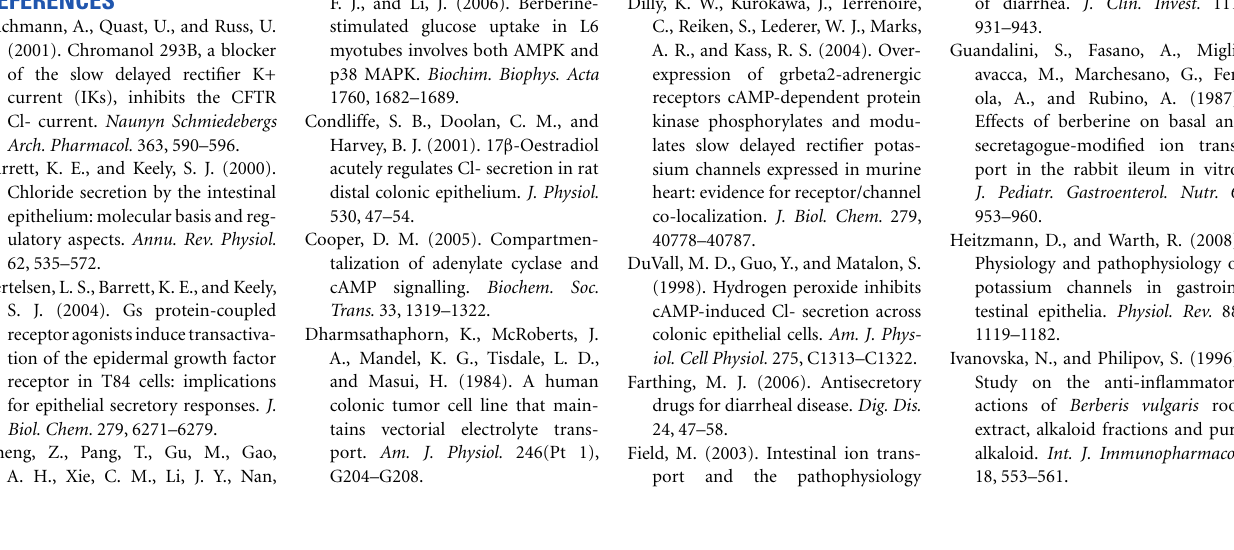
intestine via its antimotility action. Finally, as shown here,